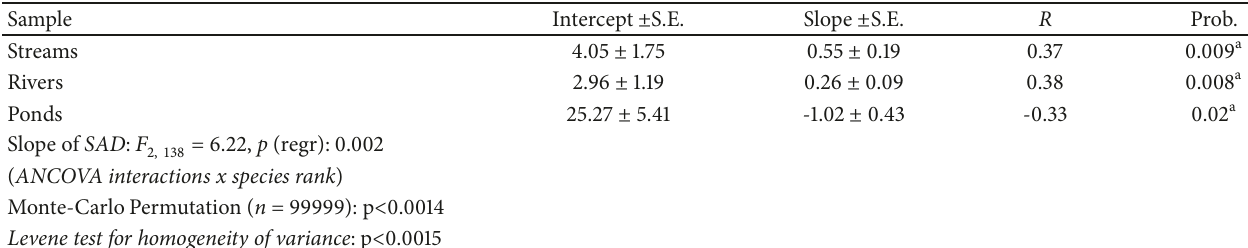
(Figure 5). Kruskal-Wallis test showed a significant differ- ence in Zygoptera species richness ( K = 16.39, p = 0.0002) and Anisoptera richness ( K = 16.51, p = 0.0003) among the water types. Pairwise comparison test showed a